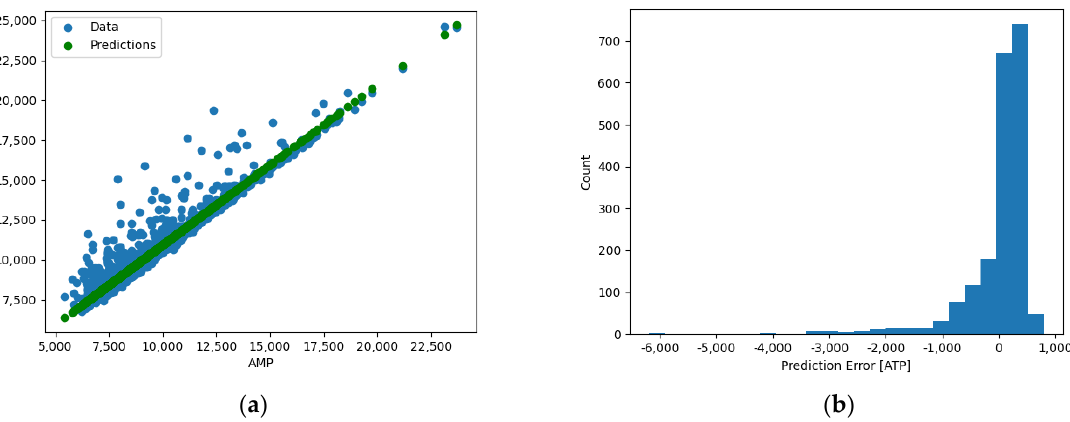
Figure 3. Perceptron results for DRG 178: ( a ) results using AMP to predict ATP and ( b ) error count.